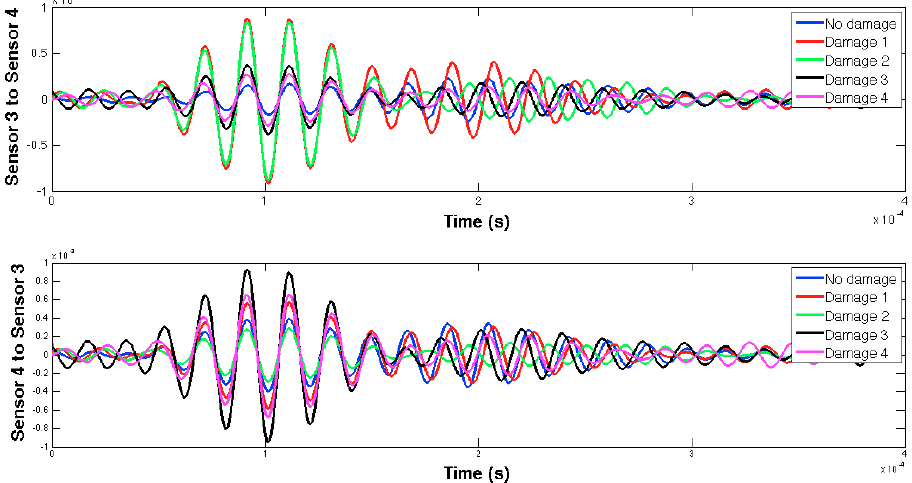
Figure 22. EMPD at 50 kHz. Tone-burst sent and measured between sensors 3 and 4.